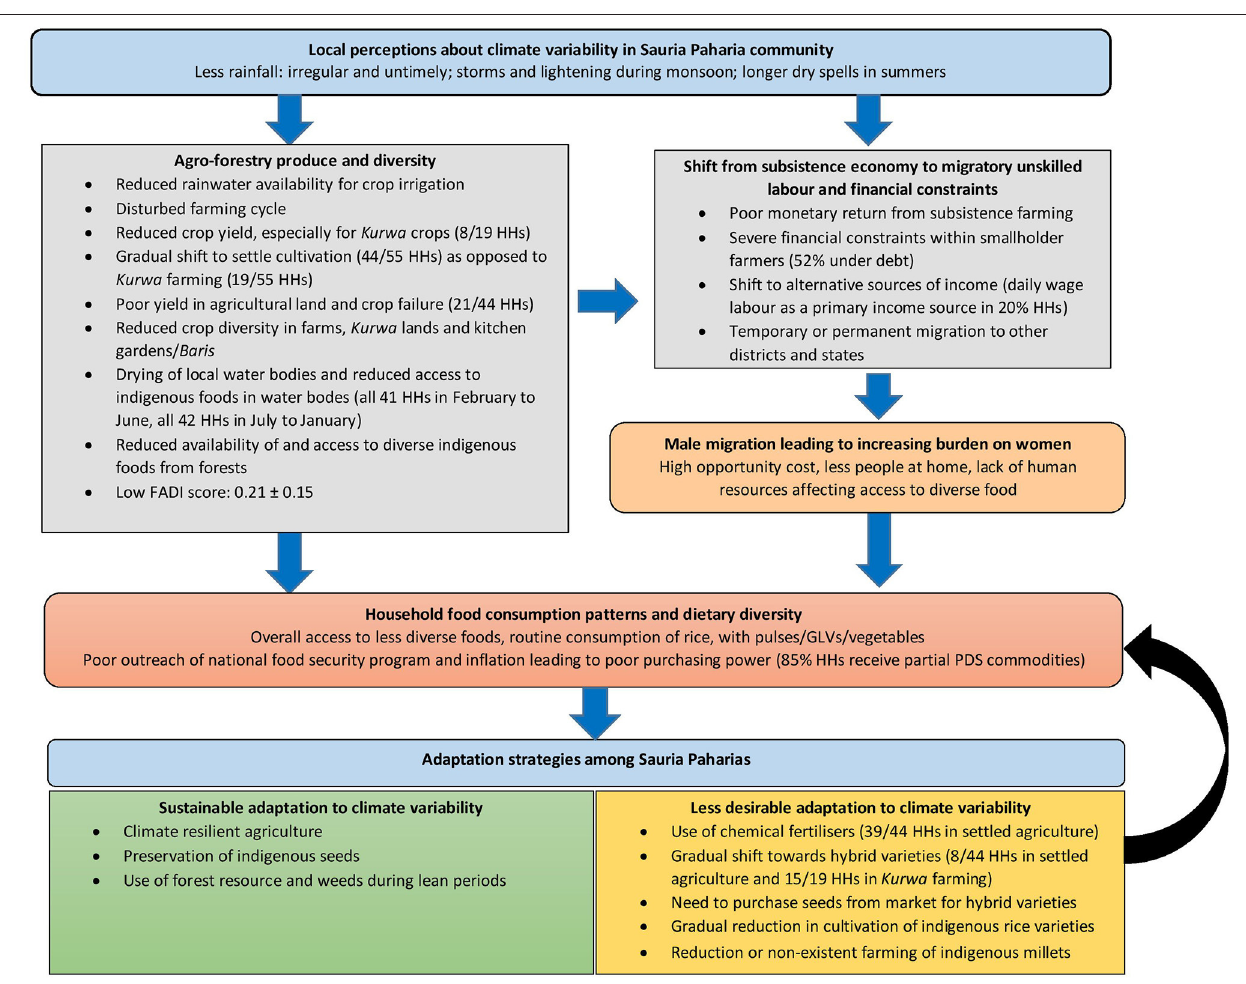
FIGURE 4 | Interconnected pathways of climate change impact on agroforestry systems, food consumption patterns, and dietary diversity among Sauria Paharias, Jharkhand, India.